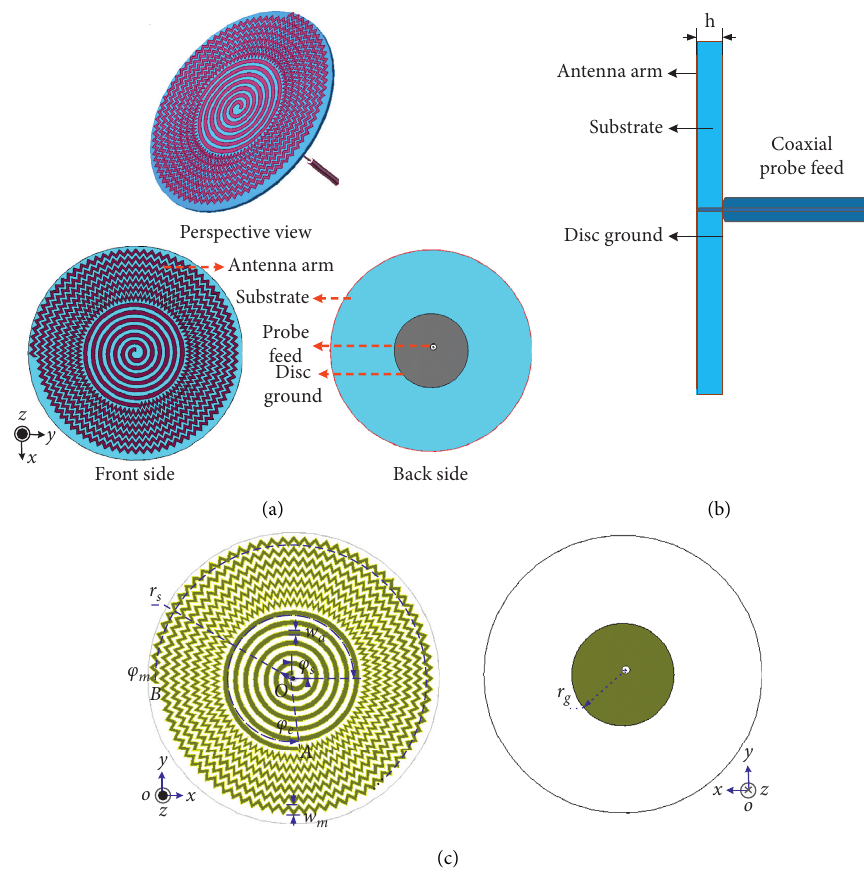
Figure 1: The SAAS antenna configuration. (a) Perspective view. (b) Side view. (c) Front view and back